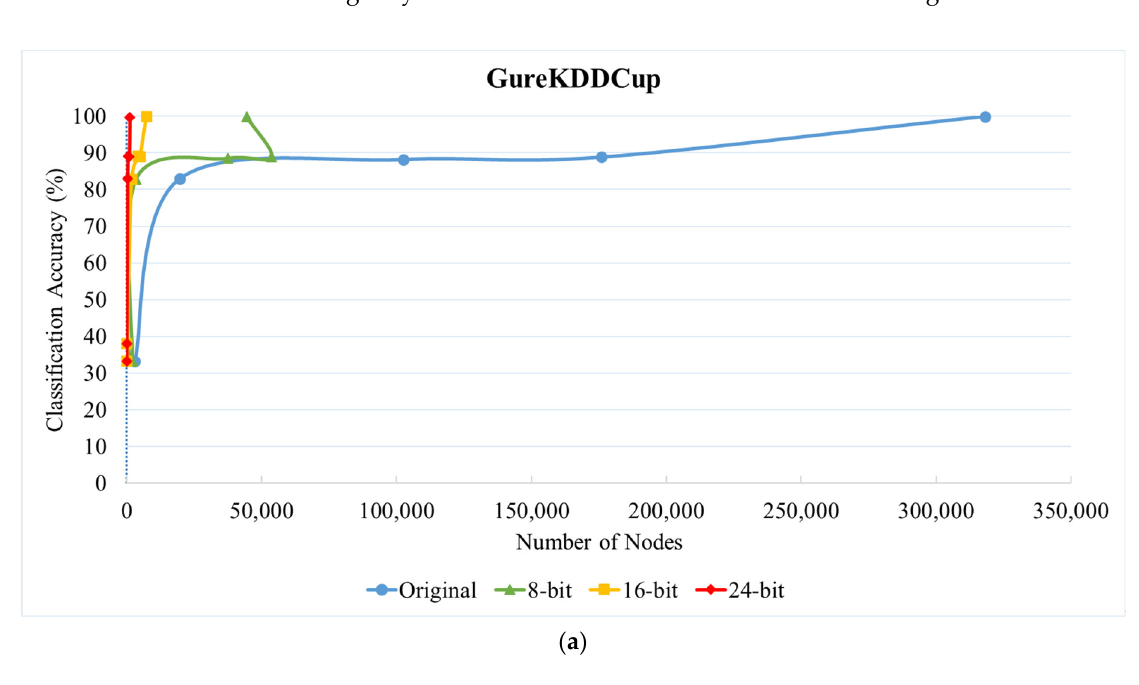
Table 6. Performance Comparison (Number of Nodes) for each C4.5 Model in Full Gure ‐ KDDCup’99, UNSW ‐ NB15, and CIDDS ‐ 001.